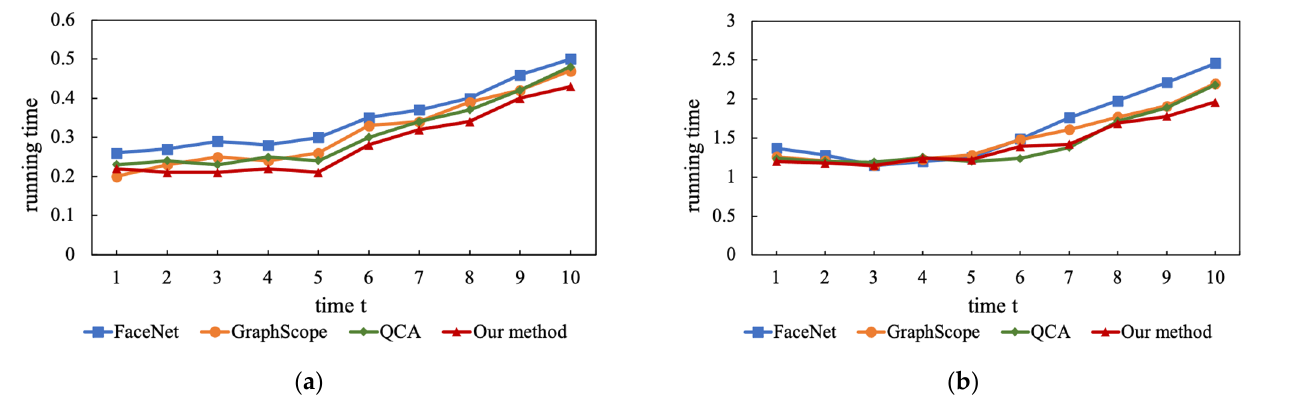
Figure 7. Running time of the four algorithms on the two datasets after manual processing. ( a ) Cora; ( b ) Wiki.